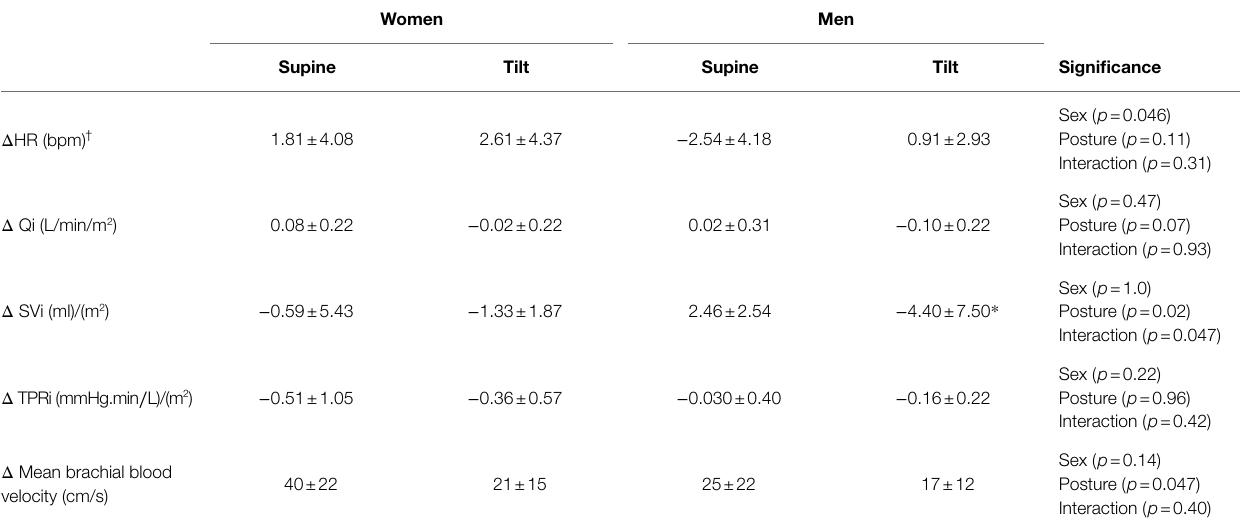
TABLE 3 | Hemodynamic changes from baseline to the time of maximal dilation of women and men across the supine and tilt in the FMD testing.